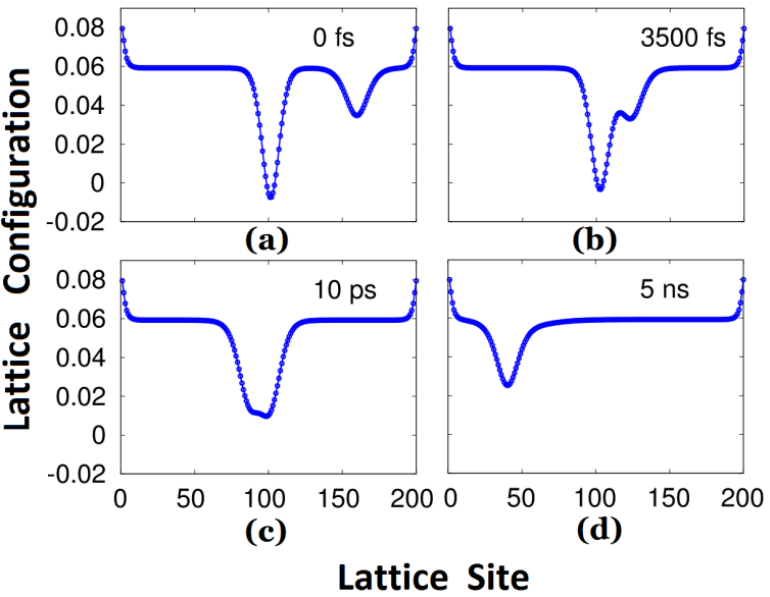
Figure 2. Evolution of the lattice configuration during the process of the interaction between the negative polaron and triplet exciton under an external electric